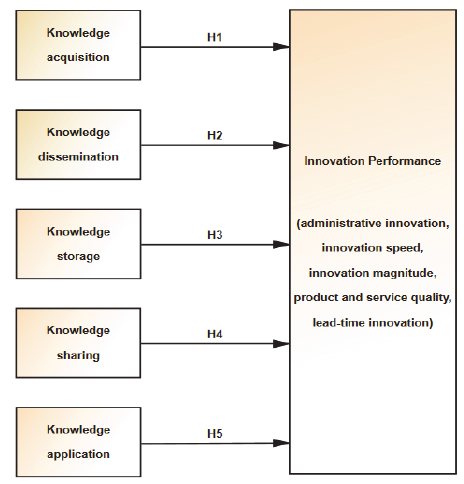
Fig. 1. Perceptual model of hypothesis H1-H5